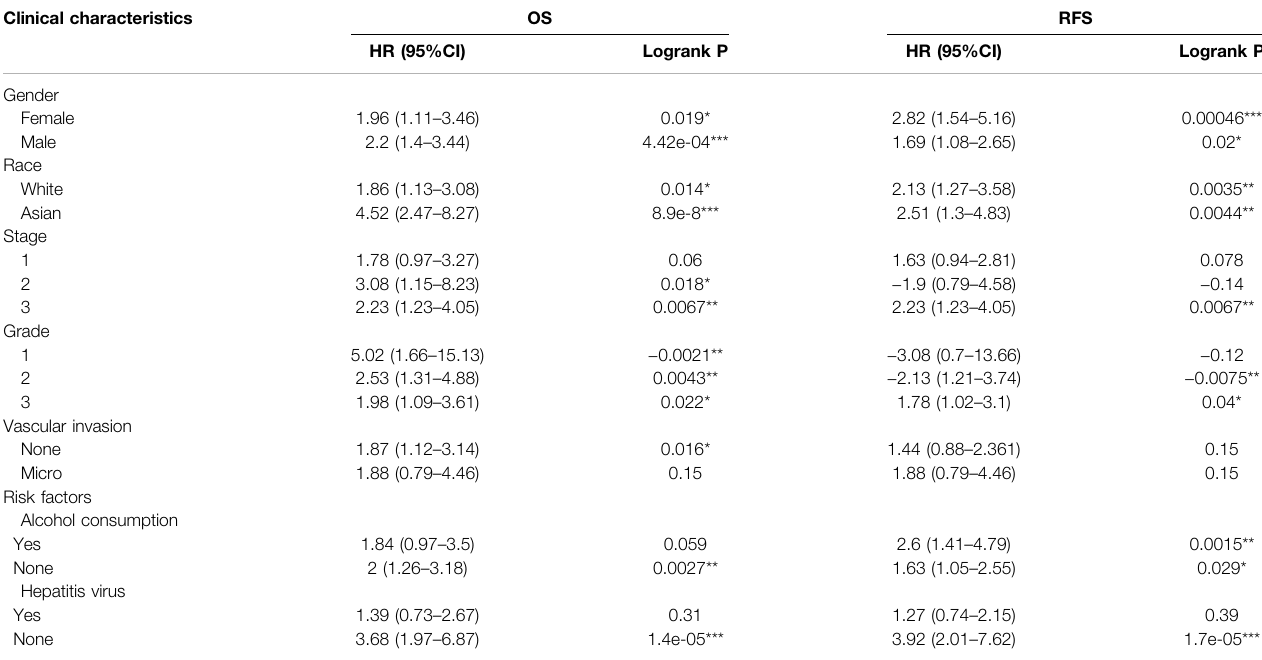
TABLE 2 | Correlation of DEPDC1B expression and clinical prognosis in LIHC with different clinical characteristics by Kaplan-Meier plotter. Clinical